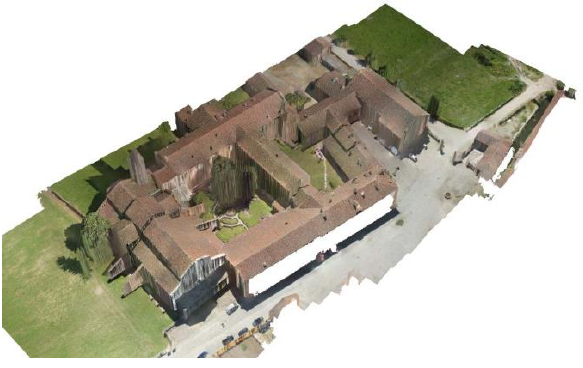
Figure 14. Textured